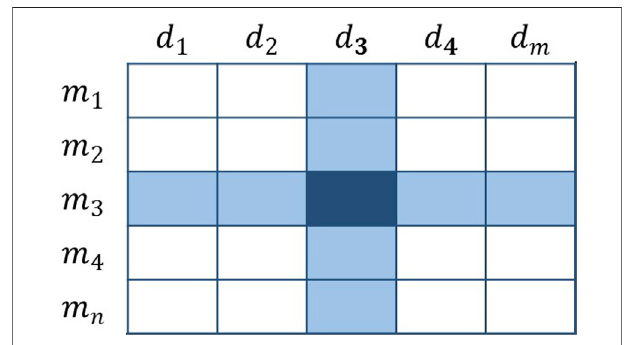
FIGURE 3 | Schematic diagram of the voting method. FIGURE 4 | The dark-colored elements represent the voters, and the